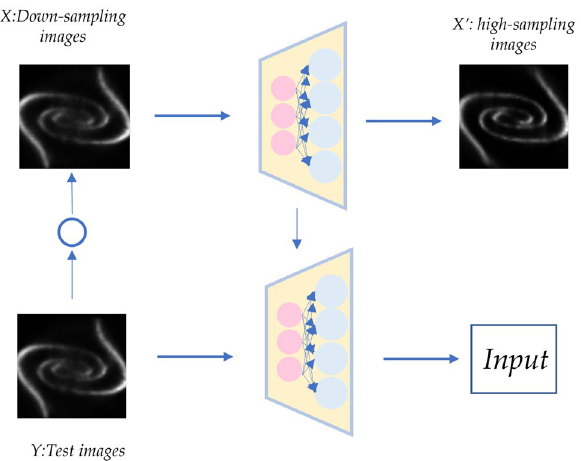
Figure 1. X represents the noisy image part of lower sampled data, X ′ represents a clearer part of the image; Y represents the test images. The proposed network model can learn a corresponding mapping relationship through the information extraction of pixels in the image, and applied to the test images on the right to obtain the output of clearer